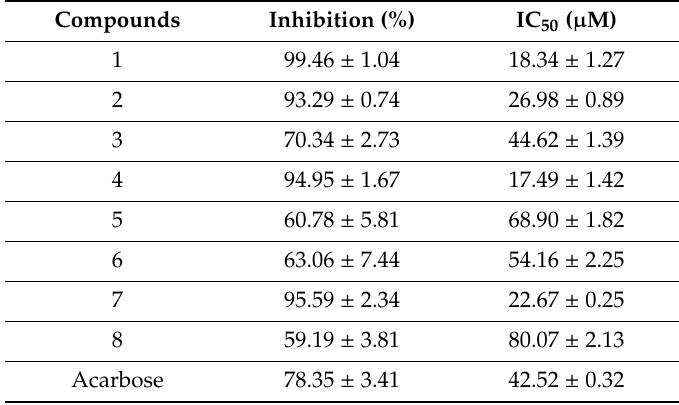
Table 2. α -Glucosidase inhibitory activities of isolates.